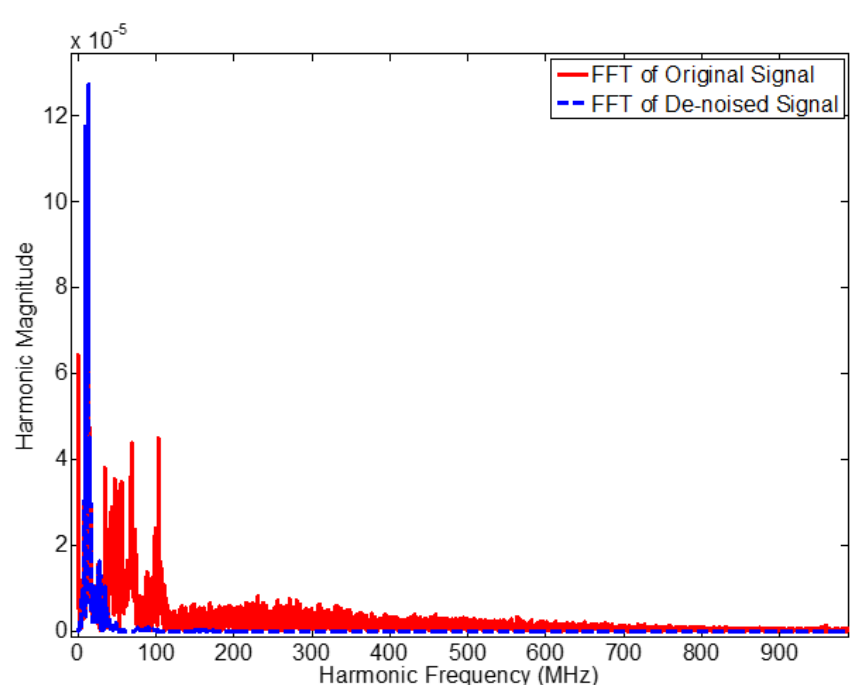
Figure 12. Original and de-noised PD signal captured by loop antenna.